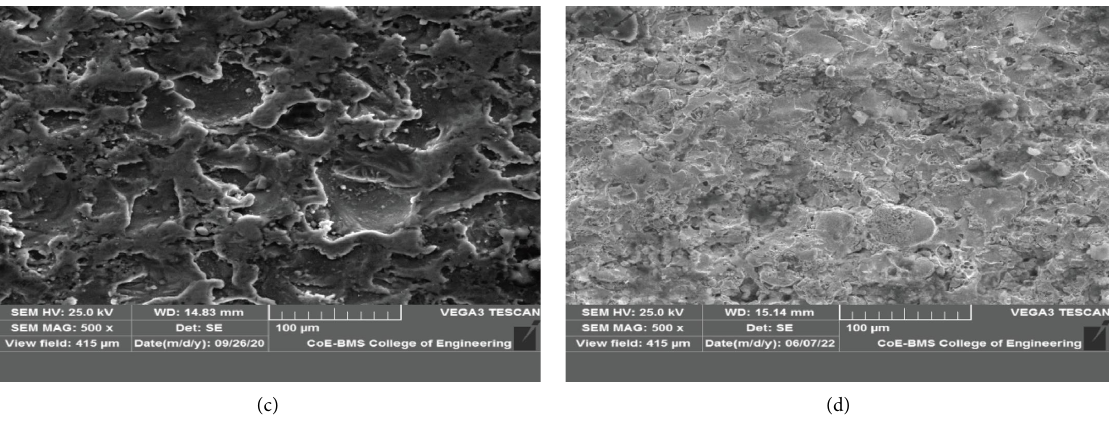
Figure 12: SEM of slurry eroded surfaces under diferent slurry speed: (a) Al6061 alloy (500 rpm), (b) coatings (500 rpm), (c) Al6061 alloy (1500rpm), and (d) coatings (1500rpm).